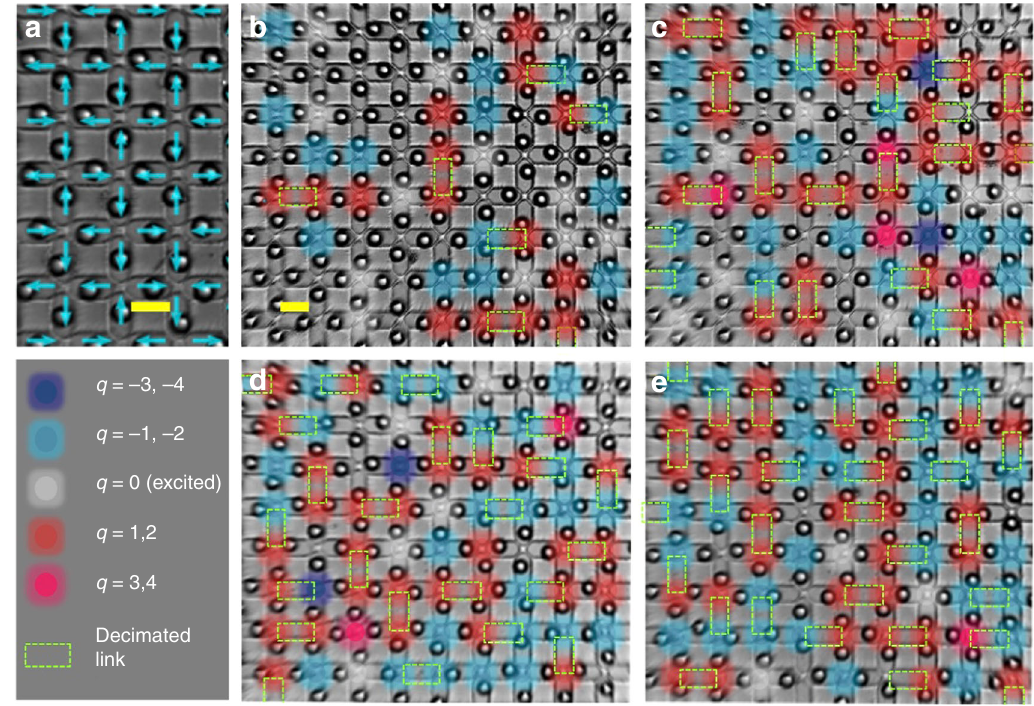
Fig. 3 Experimental results. a An experimental image of the undecimated system shows the expected antiferromagnetic ordered con fi guration. The blue arrows denote spins associated with the double wells occupied by the colloids. b – e Experimental images of the colloidal system at increasing decimation = N ¼ 0 : 19, ξ = N d / N v = 0.04, ( c ) η = 1.3158, ξ = 0.142, ( d ) η = 2.3846, ξ = 0.176 and ( e ) η = 5.2857, ξ = 0.21. Dashed corresponding to ( b ) η ¼ N z z 4 3 green rectangles denote decimated traps corresponding to z = 3 vertices. Negative charges of q = − 2 monopoles (blue glows) form on z = 4 vertices as a consequence of decimation, in violation of the ice rule. Meanwhile z = 3 vertices still obey the ice rule, but develop an overabundance of q = − 1 charges to adsorb the negative charge of the z = 4 vertices. This phenomenon increases as decimation increases. Scale bars (yellow) are 20 μ m. See Supplementary Movies 1 and 2 for corresponding movie